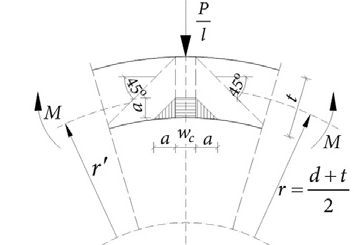
Fig. 4. Diagram of crack propagation on the thickness of the pipe wall